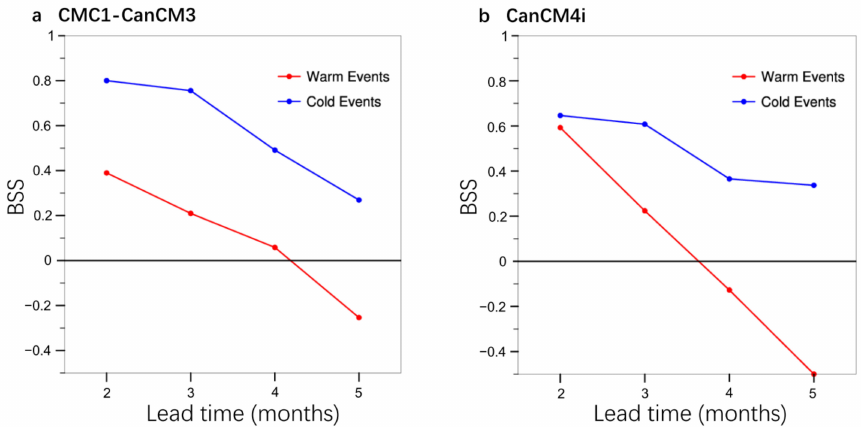
Figure 6. ( a ) The BSS as a function of lead time (month) for the Atlantic Niño prediction (red) and Atlantic Niña prediction (blue) in the model of CMC1-CanCM3. ( b ) same as ( a ) but for the models of